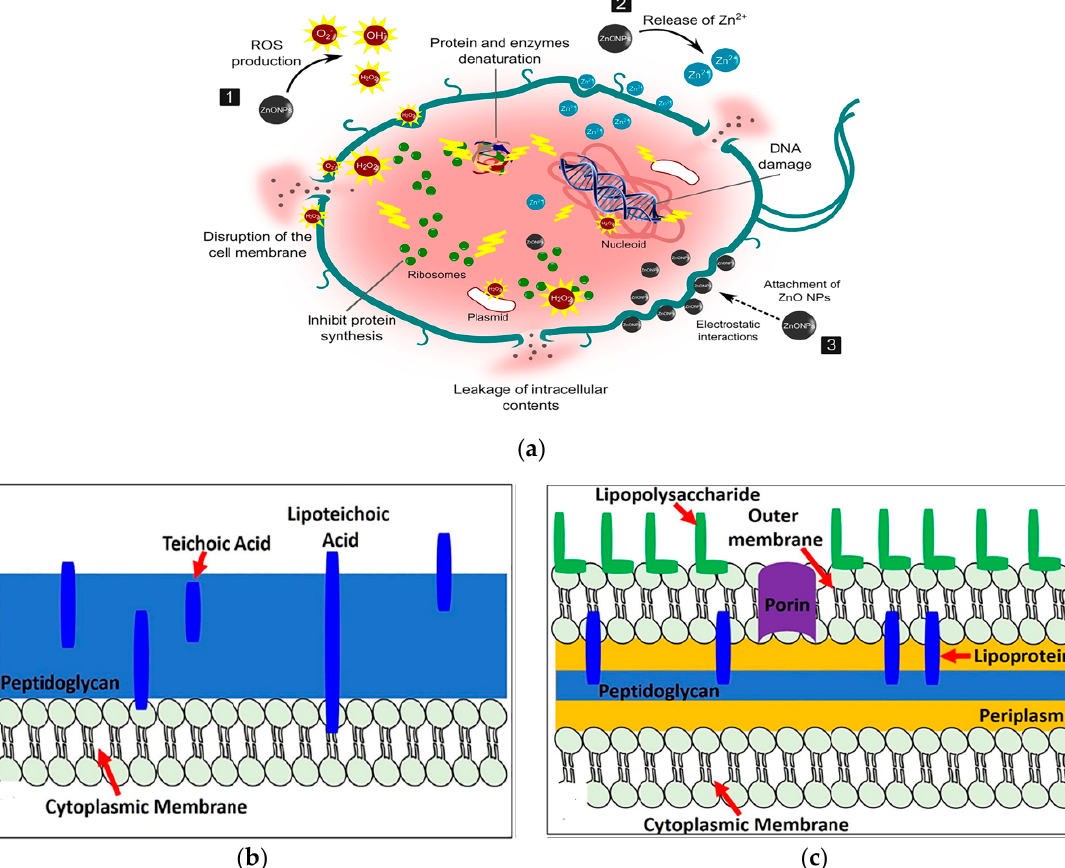
Figure 22. ( a ) Three possible mechanisms responsible for bactericidal activity of ZnO NPs: (1) The generation of reactive oxygen species (ROS), (2) release of Zn 2+ ions, and (3) direct attachment on bacterial cell membrane. Reproduced from [261] under the terms of the Creative Commons Attribution 4.0 International License. Schematics showing the cell wall structures of ( b ) Gram-positive and ( c ) Gram-negative bacteria. Reproduced from [266] under the terms of the Creative Commons Attribution License.